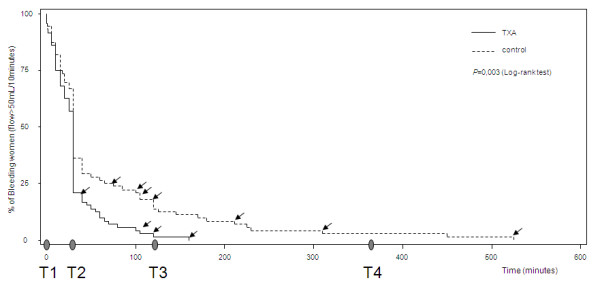
Graph showing time from enrolment until PPH cessation in the two groups. Solid line = TA group, dashed line = control group. P = 0.003 using the Kaplan-Meier logrank test. Time points of the study (T2 = T1 + 30 minutes, T3 = T1 + 2 hours, T4 = T1 + 6 hours) are indicated on the x-axis. The time of each invasive procedure is indicated by an arrow.